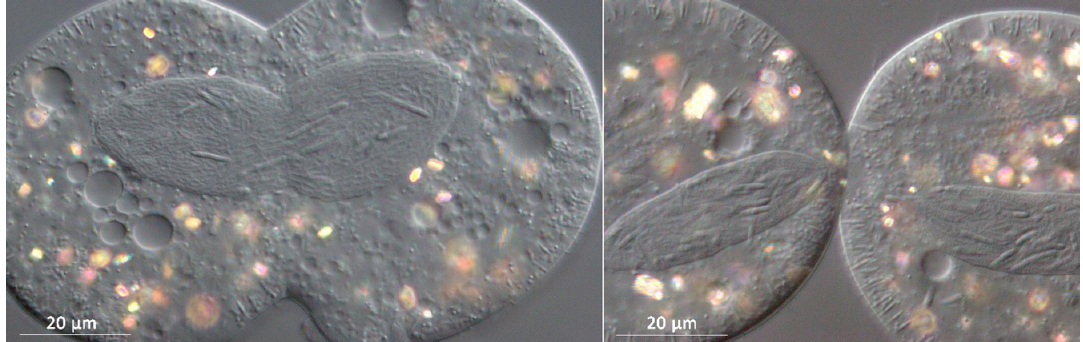
Figure 3. P. putrinum during the division process. No connecting piece is